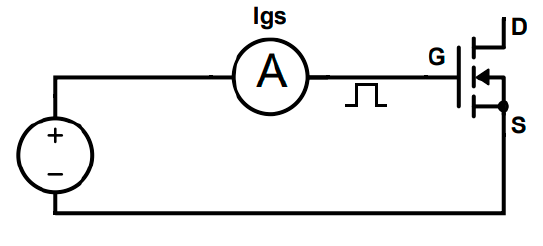
Figure 15. Calibration electrical circuit for I g.